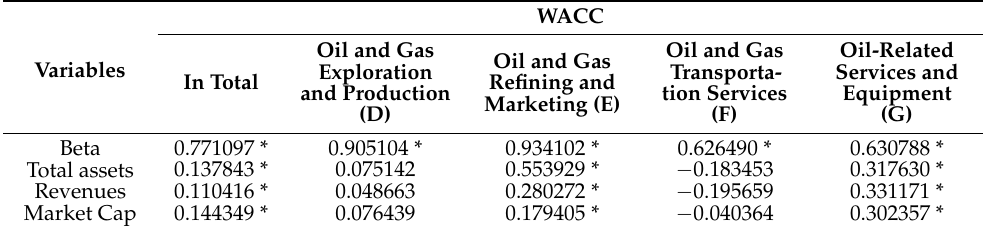
Table 7. Summary statistics correlation matrix for WACC with group division and selected variables.